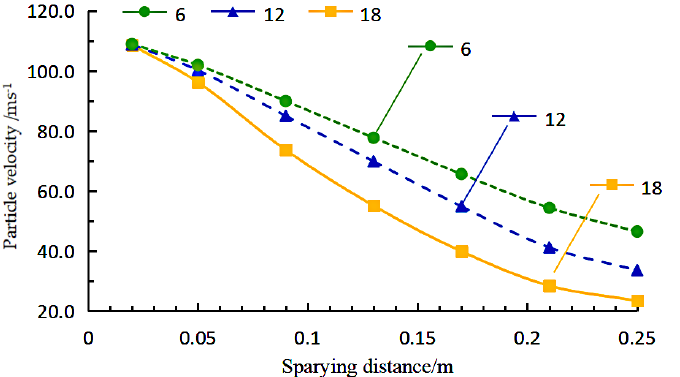
Figure 14. Variation of particle velocity with spraying distance under different critical Weber numbers.